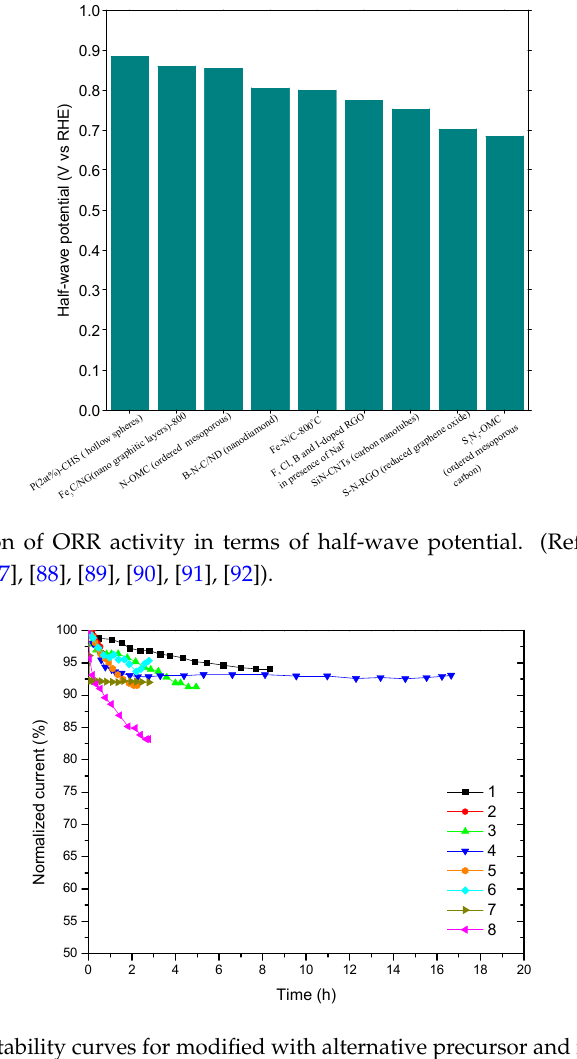
Figure 7. Long ‐ term stability curves for modified with alternative precursor and mono or dual ‐ doped Figure 7. Long-term stability curves for modified with alternative precursor and mono or dual-doped electrocatalysts: (1) NCNT ‐ 900 (N ‐ doped carbon nanotubes) (at − 0.4 V vs SCE) [40]; (2) S ‐ P ‐ N ‐ doped electrocatalysts: (1) NCNT-900 (N-doped carbon nanotubes) (at − 0.4 V vs. SCE) [40]; (2) S-P-N-doped graphitized carbon ‐ 1000 (at − 0.3 V vs SCE) [78]; (3) NOMC (N ‐ doped ordered mesoporous) (at − 0.3 V graphitized carbon-1000 (at − 0.3 V vs. SCE) [78]; (3) NOMC (N-doped ordered mesoporous) (at − 0.3 V vs Ag/AgCl) [84]; (4) P(2 at. %) ‐ CHS (phosphorus ‐ doped hollow spheres) (at 0.8 V vs RHE) [85]; (5) vs. Ag/AgCl) [84]; (4) P(2 at. %)-CHS (phosphorus-doped hollow spheres) (at 0.8 V vs. RHE) [85]; shell core structural boron and nitrogen co ‐ doped graphitic carbon/nanodiamond (BN ‐ C/ND) [87]; (6) (5) shell core structural boron and nitrogen co-doped graphitic carbon/nanodiamond (BN-C/ND) [87]; Fe ‐ N/C ‐ 800 (at − 0.3V vs Ag/AgCl) [88]; (7) SiN ‐ CNTs (at − 0.3 V vs Ag/AgCl) [90]; and (8) S ‐ doped/CNTs ‐ 900 (at − 0.3 V vs Ag/AgCl) [93]. (6) Fe-N/C-800 (at − 0.3 V vs. Ag/AgCl) [88]; (7) SiN-CNTs (at − 0.3 V vs. Ag/AgCl) [90]; and (8) S-doped/CNTs-900 (at − 0.3 V vs. Ag/AgCl)